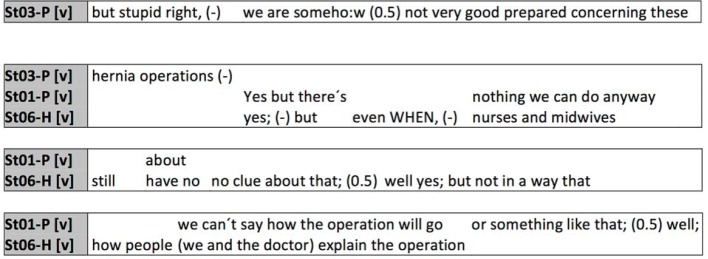
Example responses